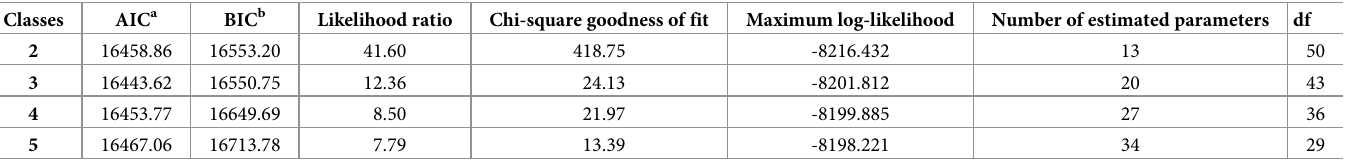
Table 3. Latent class model fit